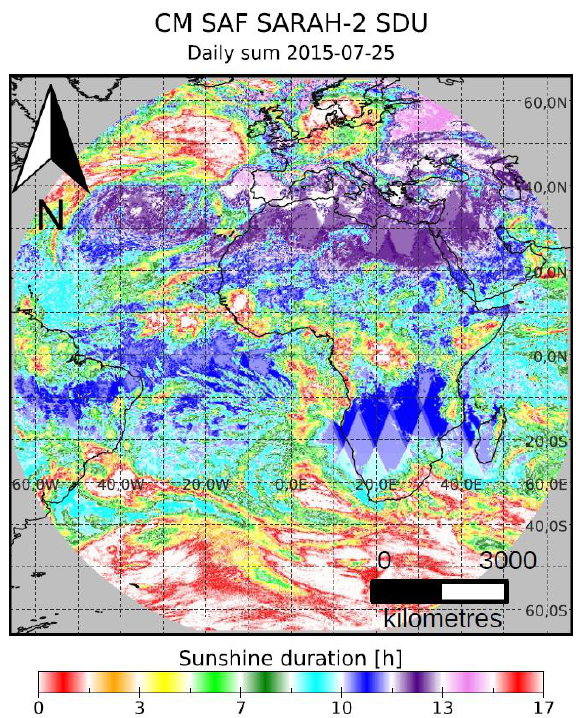
Figure 8. Daily sum SDU (h) for 25 July 2015. The colorbar highlights artificial patterns in Africa.